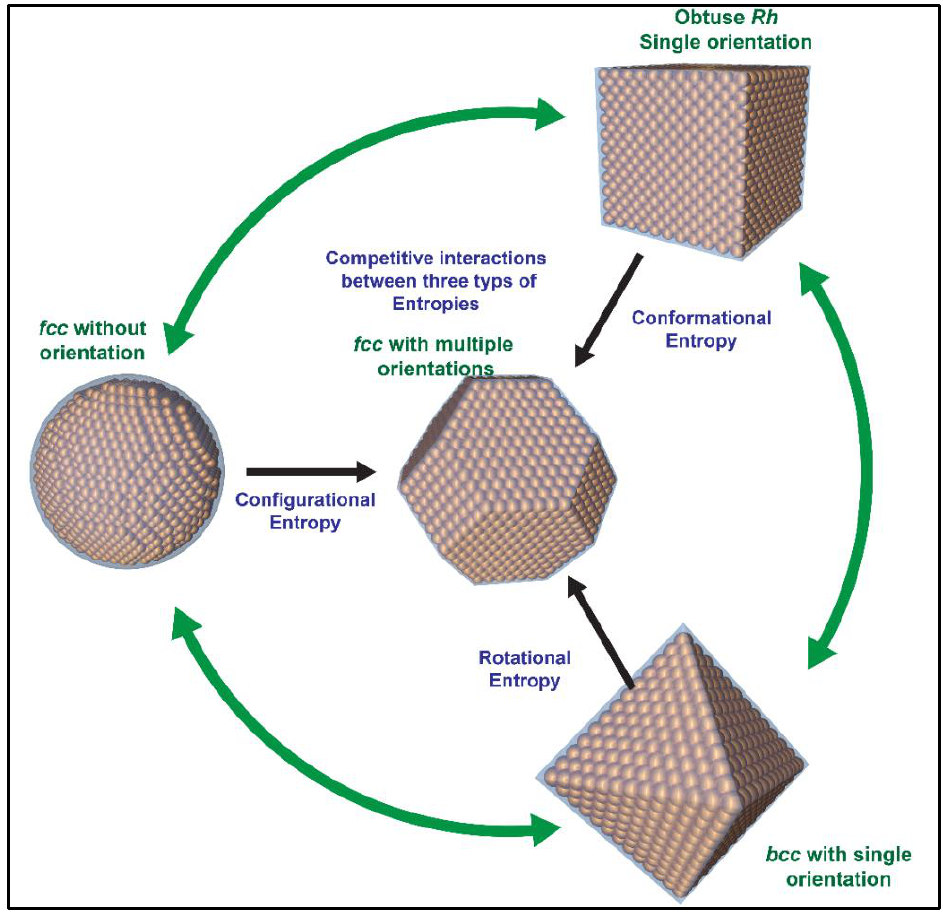
Figure 9. Dependence of various entropic forces on the NC shape over the course of NC assembly towards the formation of typical superlattices, which display various degrees of translational and orientational ordering of NCs.